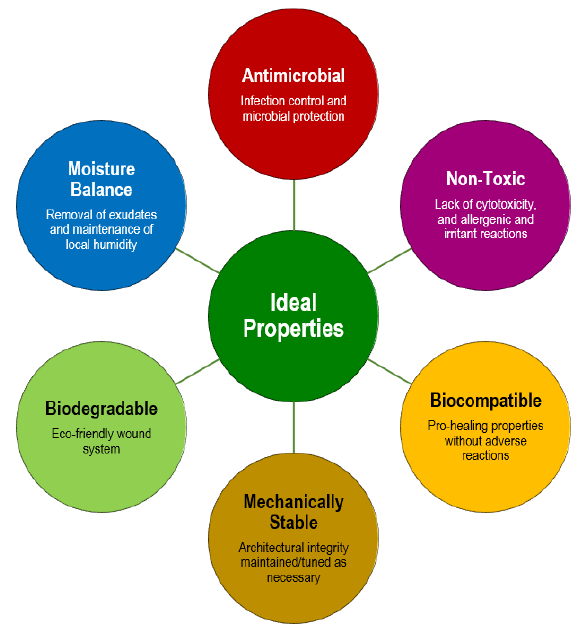
Figure 3. Requirements for the formulation of a scaffolding system for applications in DFUs therapies.